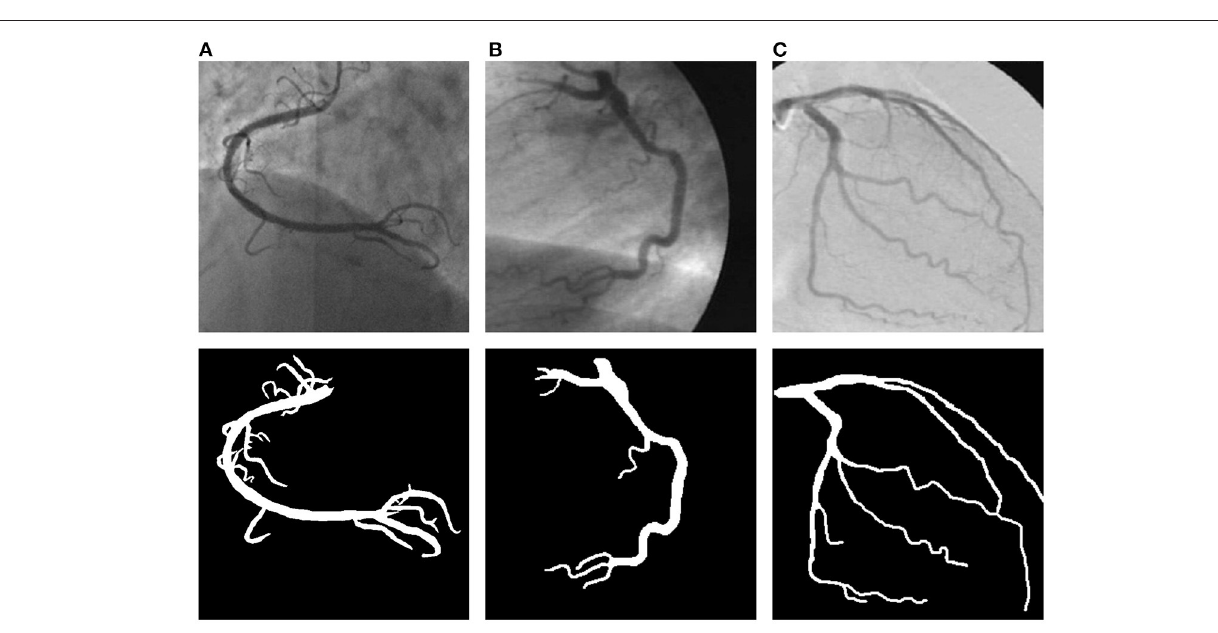
FIGURE 3 | The original angiograms and corresponding labels from the two datasets. The images in the first row are the original angiograms, while the corresponding labels are in the second row. The images in (A) column are from CCA, and the images in (B) and (C) are from DCA1.